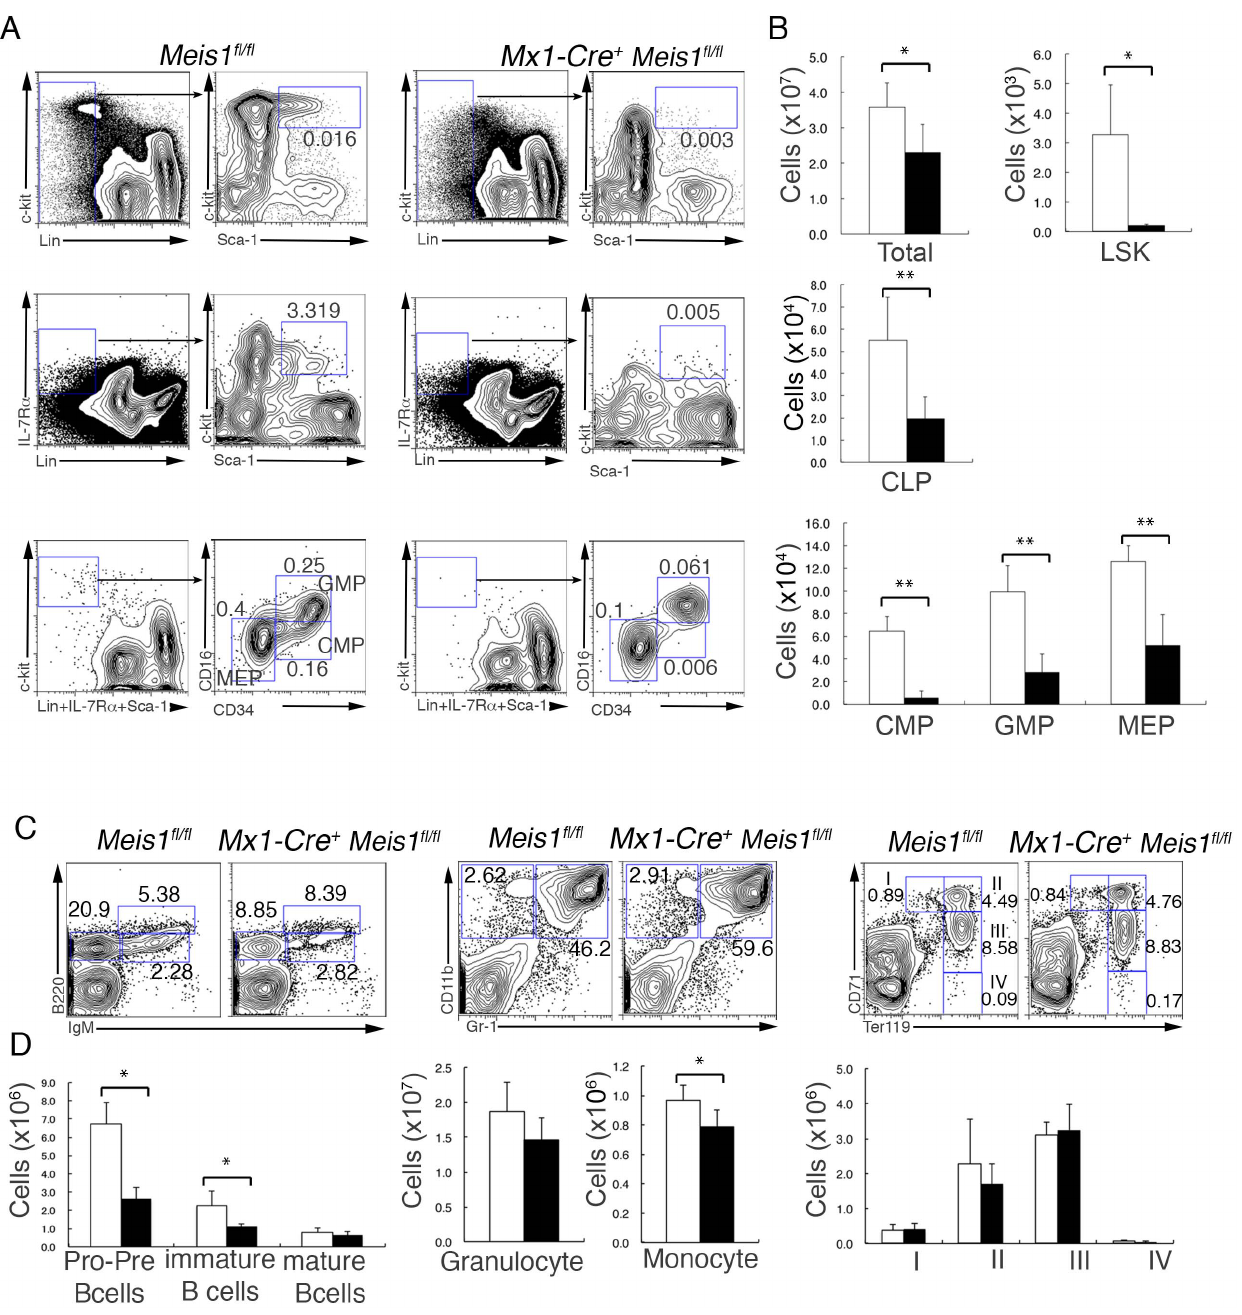
Figure 1. Loss of Meis1 leads to a depletion of hematopoietic progenitor cells from the bone marrow. (A) Representative flow cytometric profiles of hematopoietic progenitor cell populations from Mx1-Cre + Meis1 fl/fl and control Meis1 fl/fl mice three weeks after poly(I:C) treatment. Gates used to identify progenitor populations are outlined, and rightward arrows within the plots indicate their relationship to subsequent plots showing the progenitor populations. Numbers adjacent to outlined areas indicate percentage of gated cells in total BM mononuclear cells. (B) Absolute numbers of the indicated cell populations per two femurs in poly(I:C)–treated Mx1-Cre + Meis1 fl/fl (solid bars) and control Meis1 fl/fl (open bars) mice (mean and SD; n=4). (C) Representative flow cytometric profiles of lineage-committed cell populations. (D) Absolute numbers of the indicated cell populations per two femurs in poly(I:C)–treated Mx1-Cre + Meis1 fl/fl (solid bars) and control Meis1 fl/fl (open bars) mice (mean and SD; n=4). Pro- and pre-B cells (B220 low IgM 2 ), immature B cells (B220 low IgM + ), mature B cells (B220 + IgM + ), granulocytes (Gr-1 + CD11b + ), monocytes (Gr-1 2 CD11b + ), proerythroblasts (I; Ter119 low CD71 high ), basophilic erythroblast (II; Ter119 high CD71 high ) and late erythroblasts (III; Ter119 high CD71 int and IV; Ter119 high CD71 low ). *p , 0.05 and **p , 0.01.